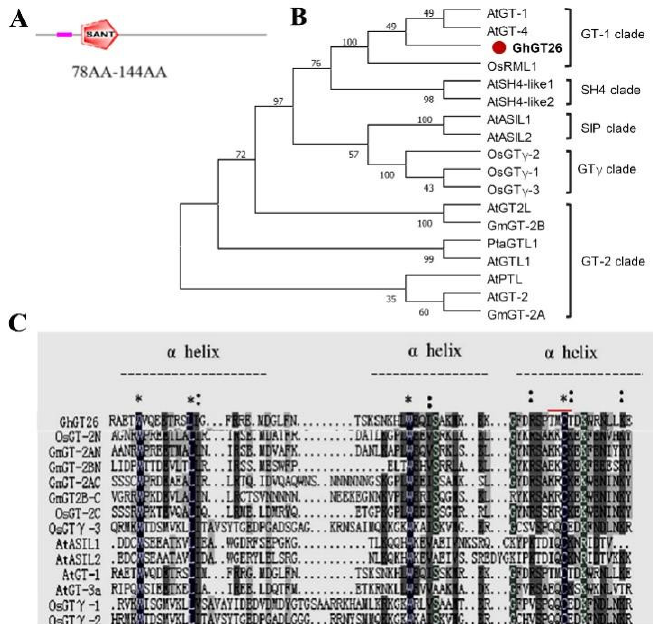
Figure 1. Schematic representation and amino acid sequence alignment of GhGT26. ( A ) Schematic diagram of GhGT26. ( B ) Phylogenetic analysis of GT proteins from different species. The phylogenetic tree was constructed using the maximum likelihood method with the substitution model JTT+G and 1000 bootstrap replications. GhGT26 is highlighted in the red dot. ( C ) Amino acid sequence alignment among different plant GT protein amino-terminal and carboxyl-terminal trihelix DBD. * indicates the highly conserved amino acid, : indicates the partly conserved amino acid, dotted line denotes α-helices in the trihelix DBDs. The red line indicates putative bipartite NLSs. The sequences are from rice, soybean, poplar, and Arabidopsis plants. GT-1 clade: AtGT-1 (At1g13450), AtGT-4 (At3g25990); GT-2 clade: AtGT-2 (At1g76890), AtGTL1 (At1g33240), AtGT2L (At5g28300), AtPTL (At5g03680), GmGT-2A (EF221753), GmGT-2B (EF221754), PtaGTL1 (JN113092); SH4 clade: AtSH4-like1 (At2g35640), AtSH4-like2 (At1g31310); GTγ clade: OsGTγ-1 (Os02g33770), OsGTγ-2 (Os11g06410), OsGTγ-3 (Os12g06640); SIP clade: AtASIL1 (At1g54060), AtASIL2 (At3g14180).